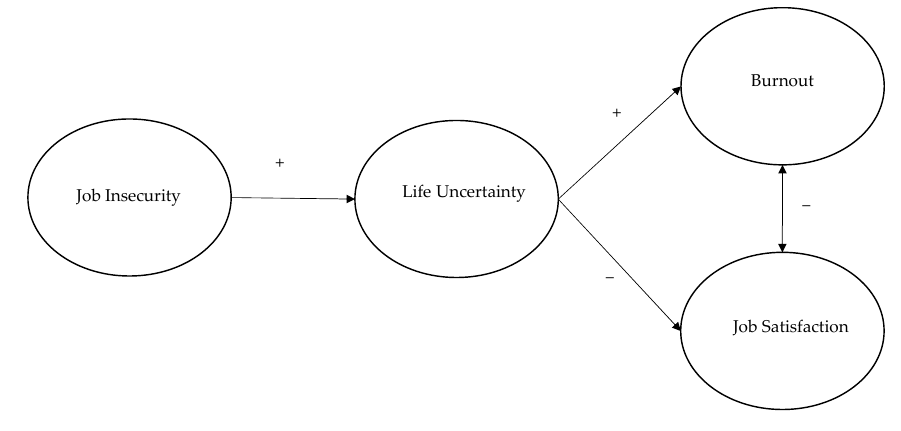
Figure 1. The theoretical model.